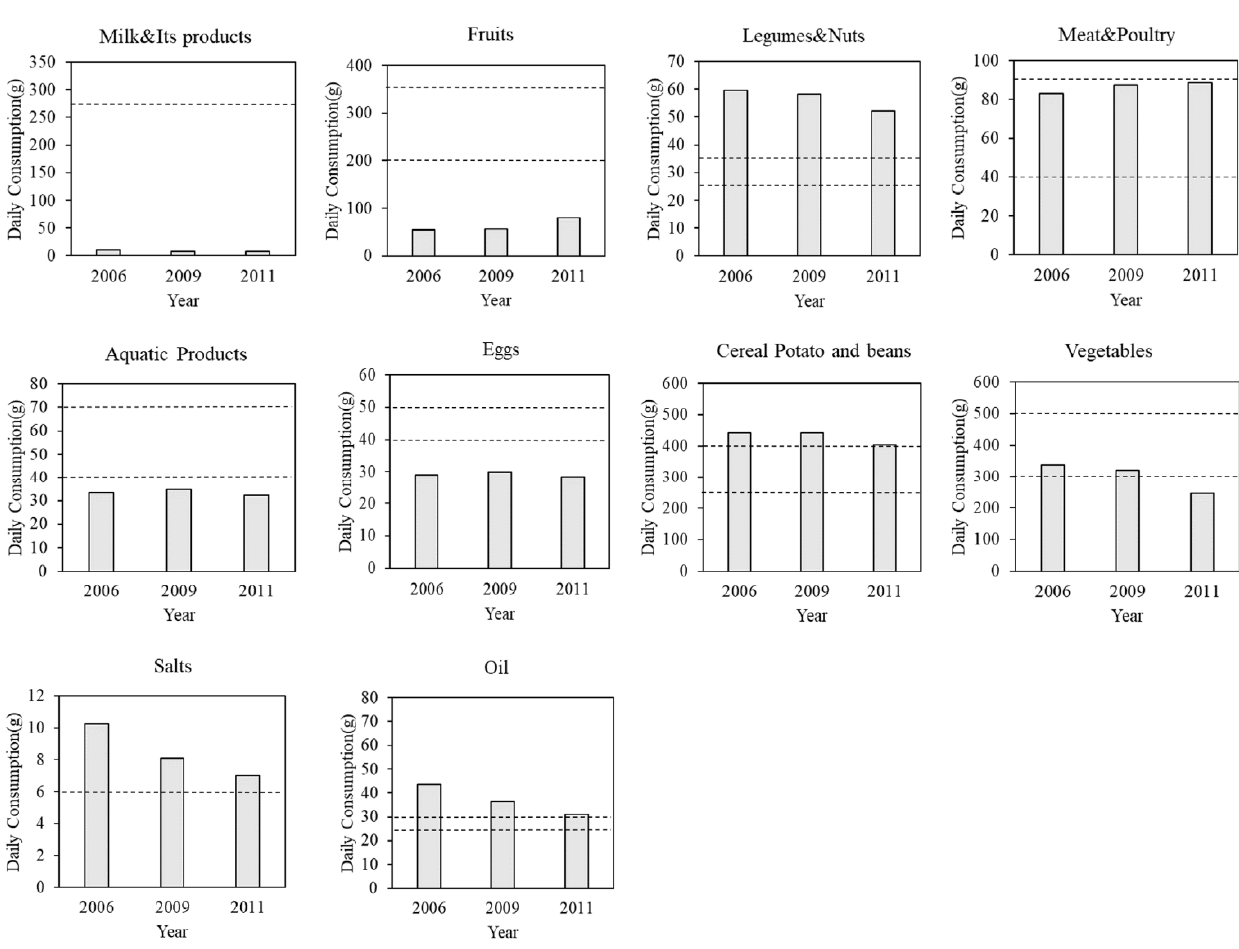
Figure 1. Actual consumption of various food groups by rural residents in China (2006–2011). Source : Author calculated by CHNS.